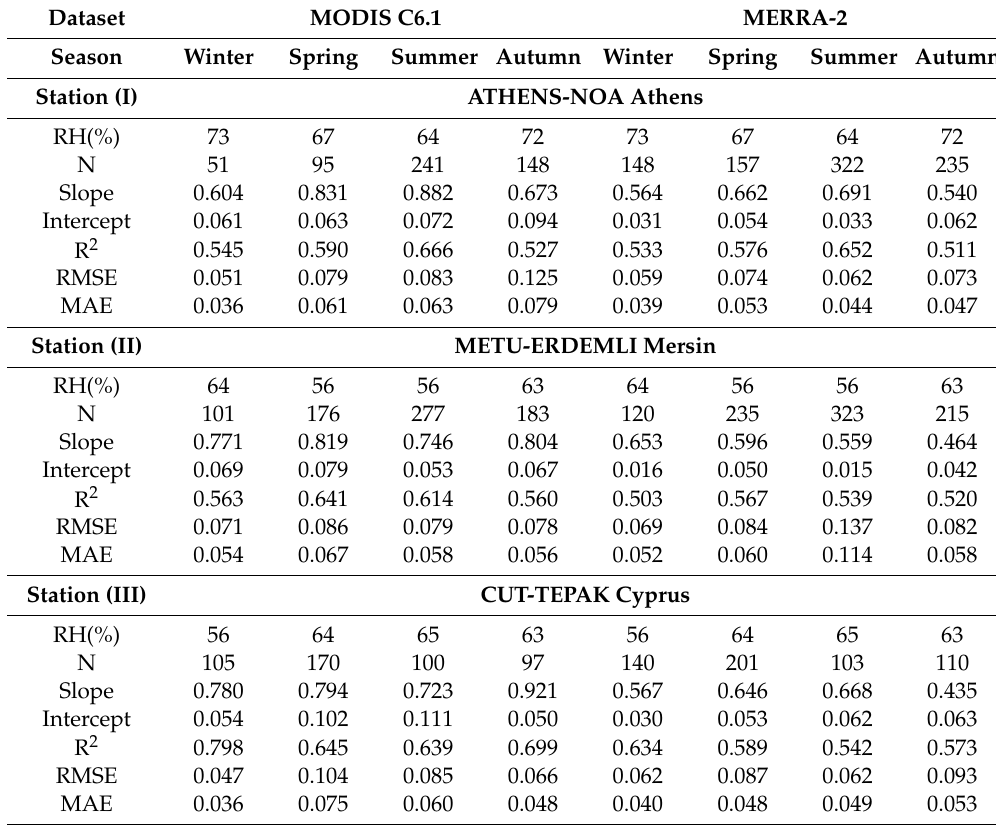
Table 2. Statistical metrics of MODIS and MERRA-2 AOD against AERONET AOD according to season for the stations (I) Athens-NOA, (II) METU-ERDEMLI, and (III)